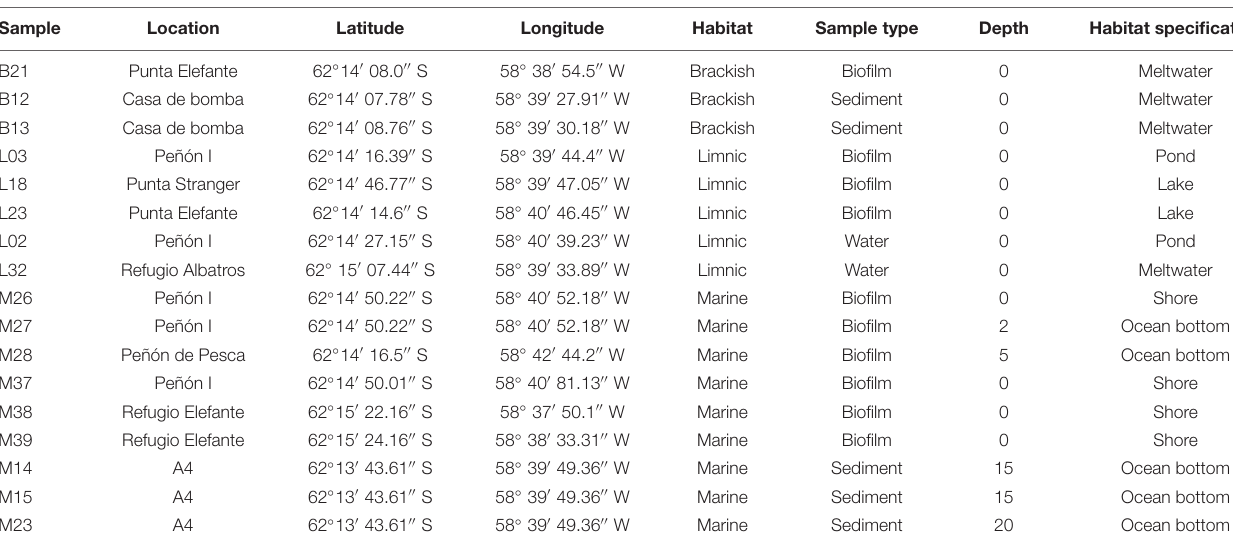
FIGURE 1 | Sampling sites in the Potter Cove area (South Shetland Islands, western Antarctic Peninsula). TABLE 1 | Sample points